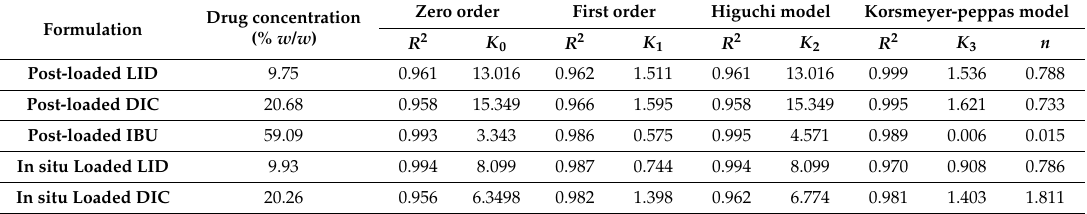
Table 9. Effect of loading method and drug physicochemical properties on the release kinetics.